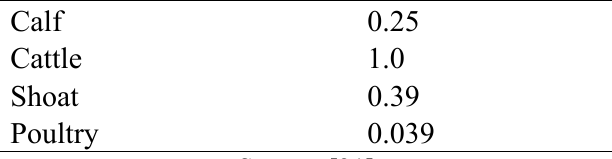
Table 2. Tropical livestock